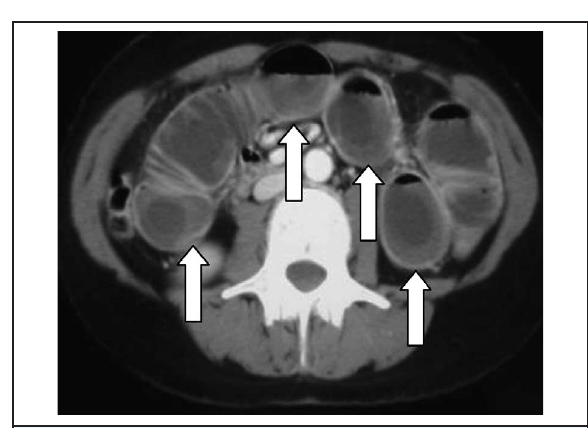
Figure 7. Contrast enhanced CT scan indicates obstructed ileal loops with air–fluid levels, thin, multiple valvulae conniventes and circumferential mild thickening bowel walls, the “target” sign (white